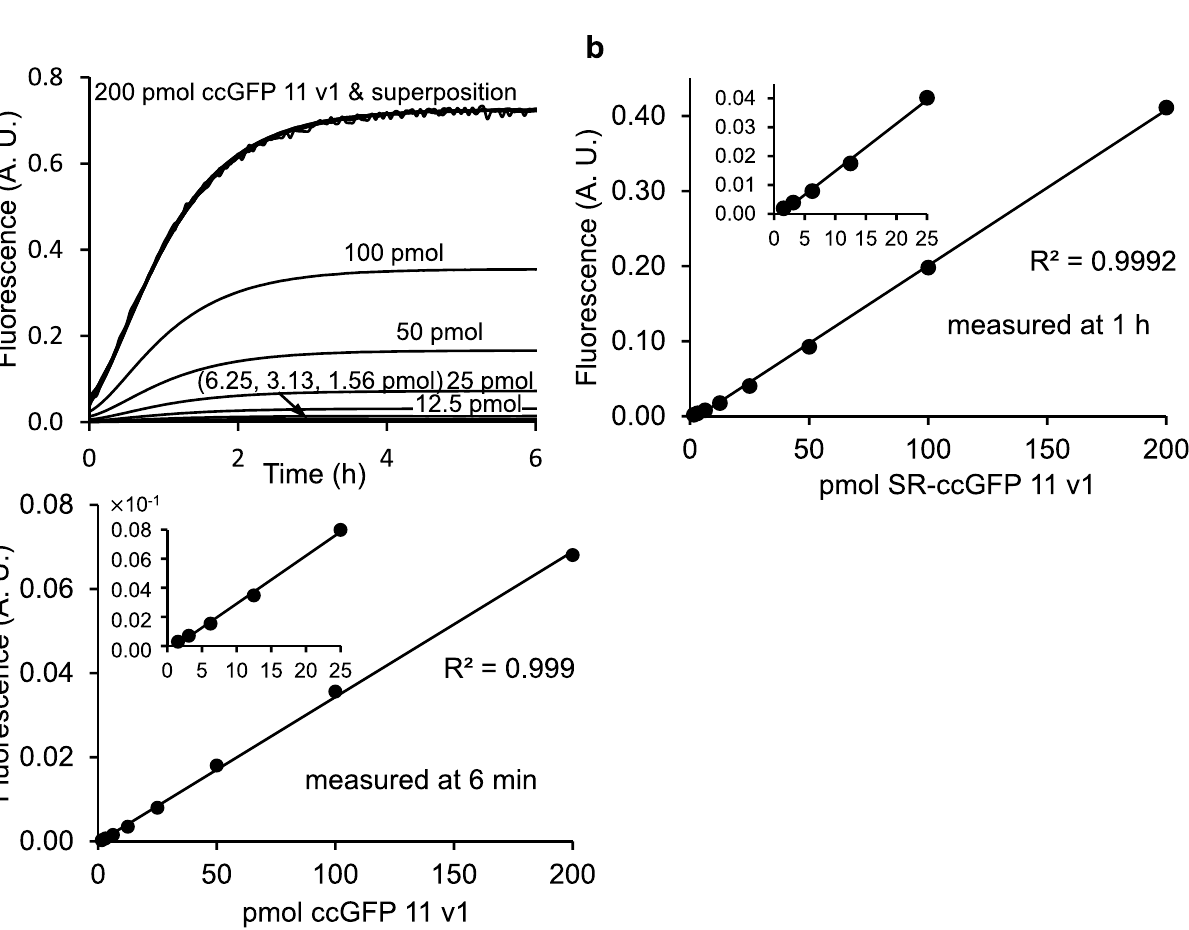
Figure 3. In vitro characterization of split ccGFP complementation. ( a ) Superimposition of scaled progress curves for complementation of 200, 100, 50, 25, 12.5, 6.25, 3.13 and 1.56 pmol SR-ccGFP S11 v1 in 20 µl aliquots, mixed with 180 µl aliquots containing 800 pmol of ccGFP 1–10 v2. Maximum signal (~ 0.8) corresponds to 45,000 fluorescence units on BioTek instrument scale (99,999 full scale). Progress curves were normalized by dividing measured fluorescence by the fluorescence of sfGFP control to compensate for instrument baseline drift (Supplementary Fig. S8). The curves can be superimposed by linear scaling indicating that the shape of the progress curve does not depend on the concentration of the tagged protein or depletion of the pool of unbound ccGFP 1–10 fragment. Note, in the superposition (top), noisy traces naturally result from the required scaling of the lowest concentration progress curves. ( b ) In vitro sensitivity of SR-ccGFP S11 v1 complementation with ccGFP 1–10 v2. Values of progress curves at 1 h from ( a ) are plotted vs. concentration of SR-ccGFP S11 v1. ( c ) Same as Fig. 3b, but data from ( a ) taken at 6